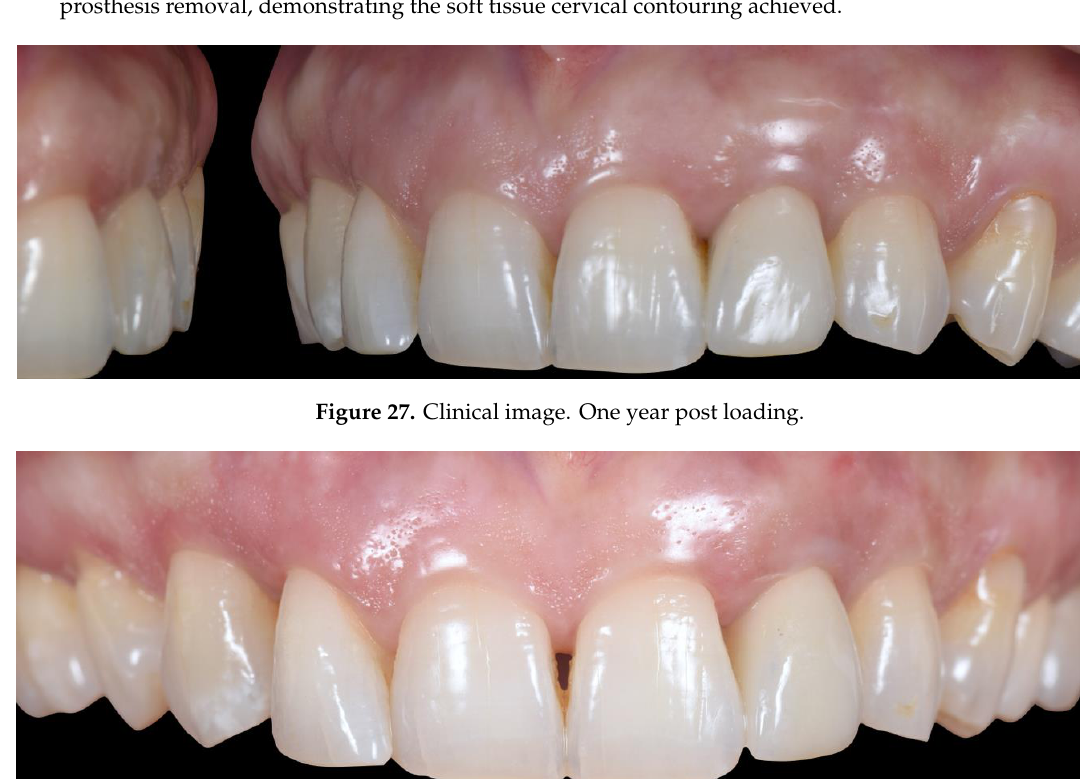
Figure 26. Clinical images at time of first temporary prosthesis removal and at time of transitional prosthesis removal, demonstrating the soft tissue cervical contouring achieved.